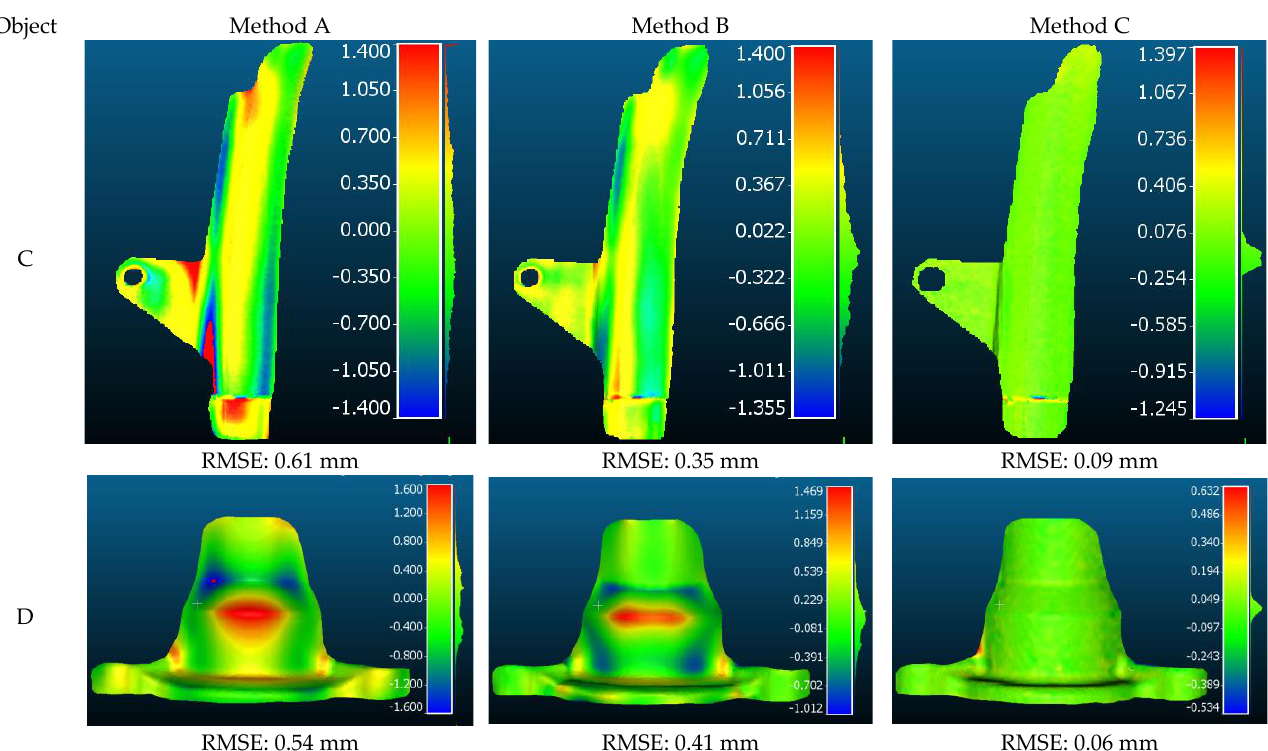
Figure 12. Cloud-to-cloud comparisons for the proposed methods on objects C and D featuring complex geometry.